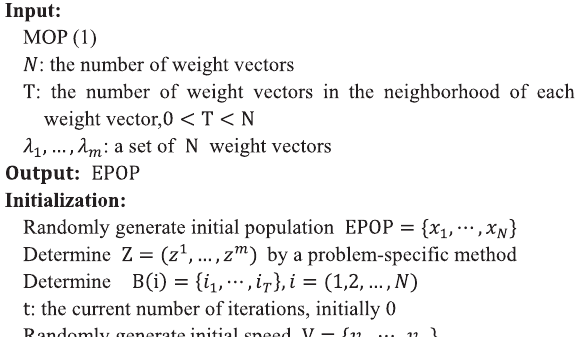
FIGURE 1 | PIO/D algorithm fl